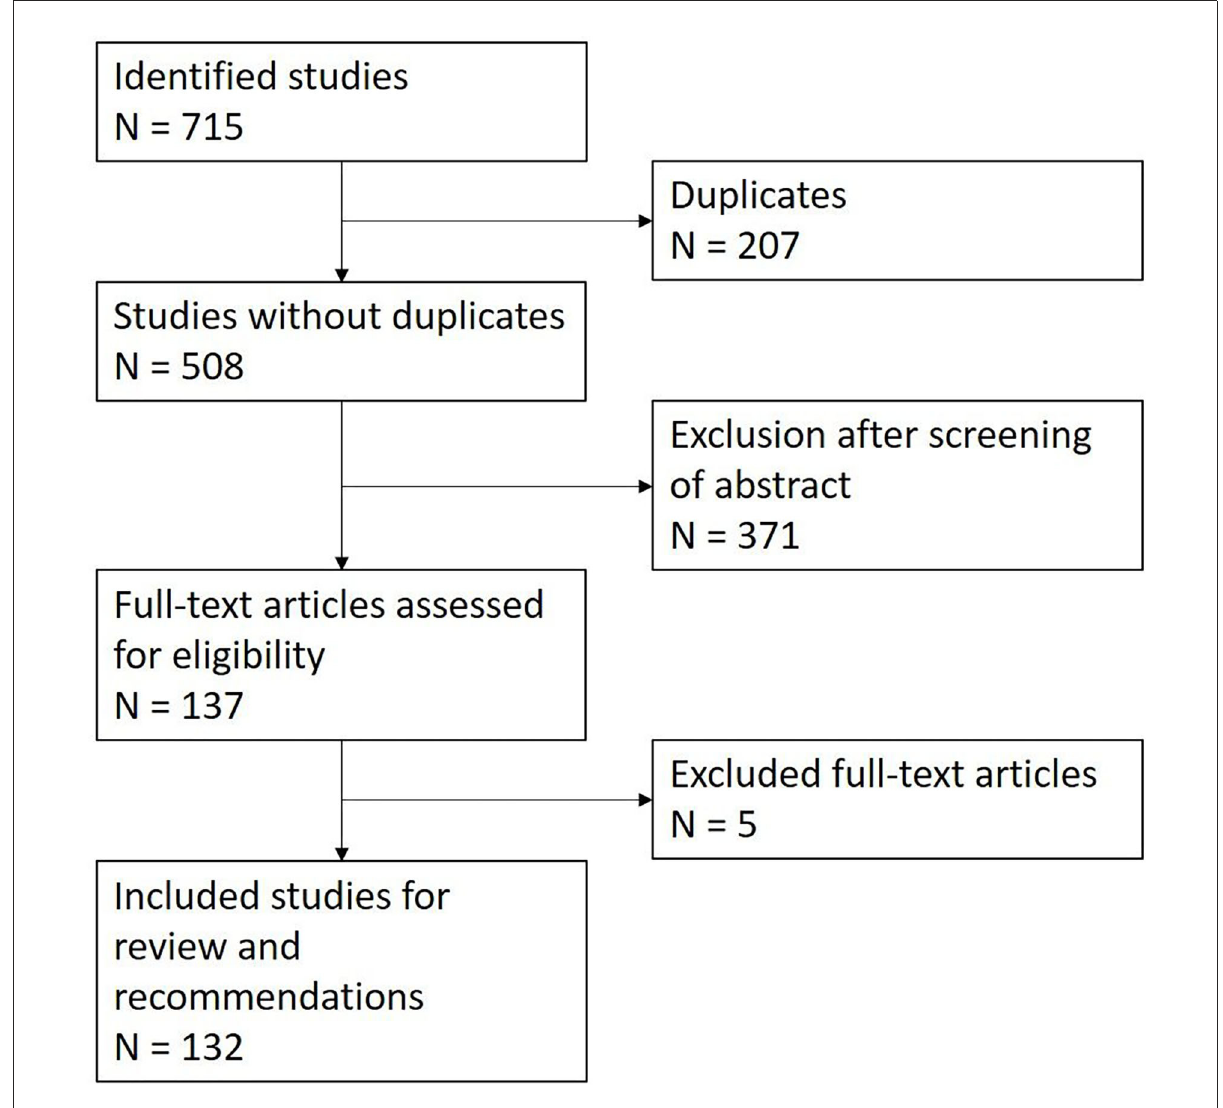
FIGURE1 Flow diagram of the literature selection